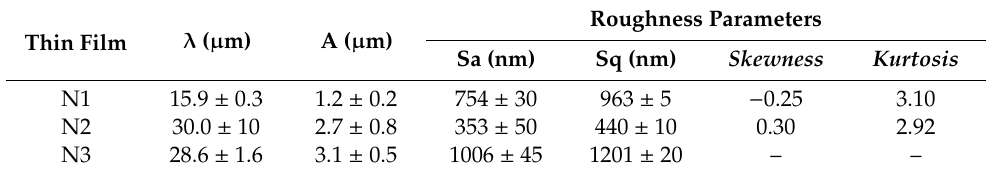
Table 1. Wavelength, amplitude, and micrometer roughness parameters, determined by IFM, of the PA thin films deposited onto PDMS substrates.